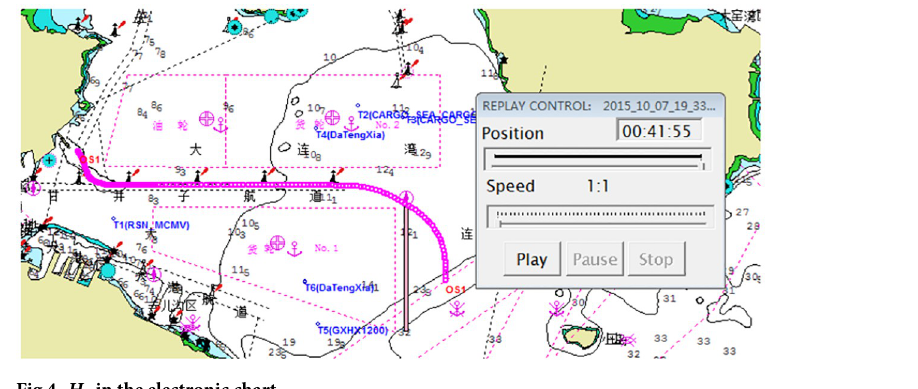
Fig 4. H in the electronic chart. d